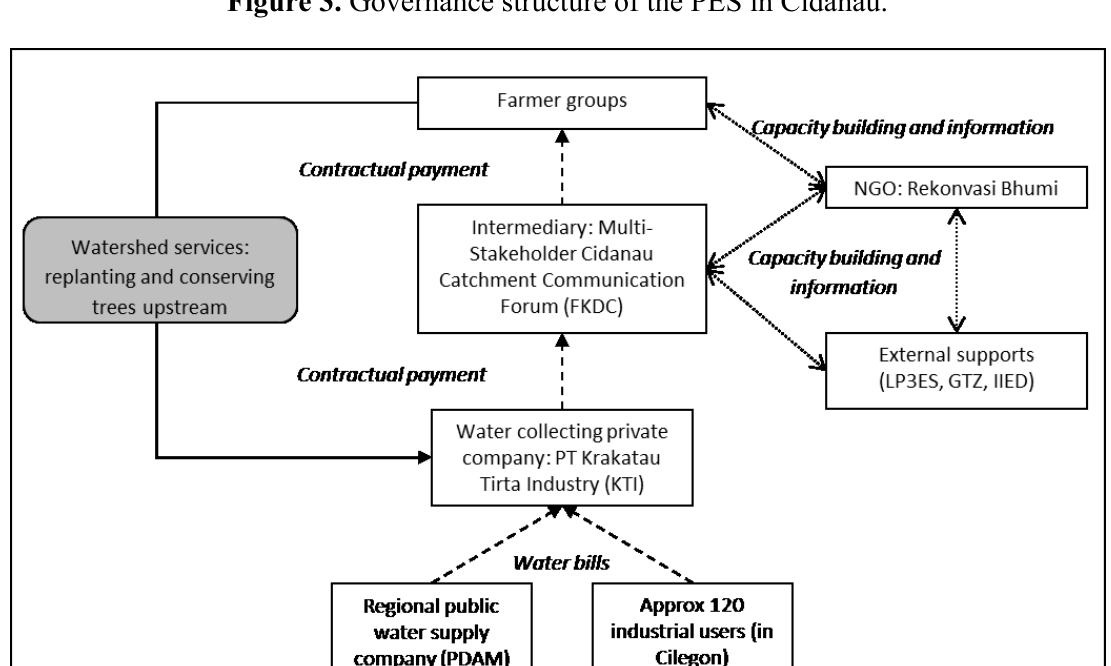
Figure 3. Governance structure of the PES in